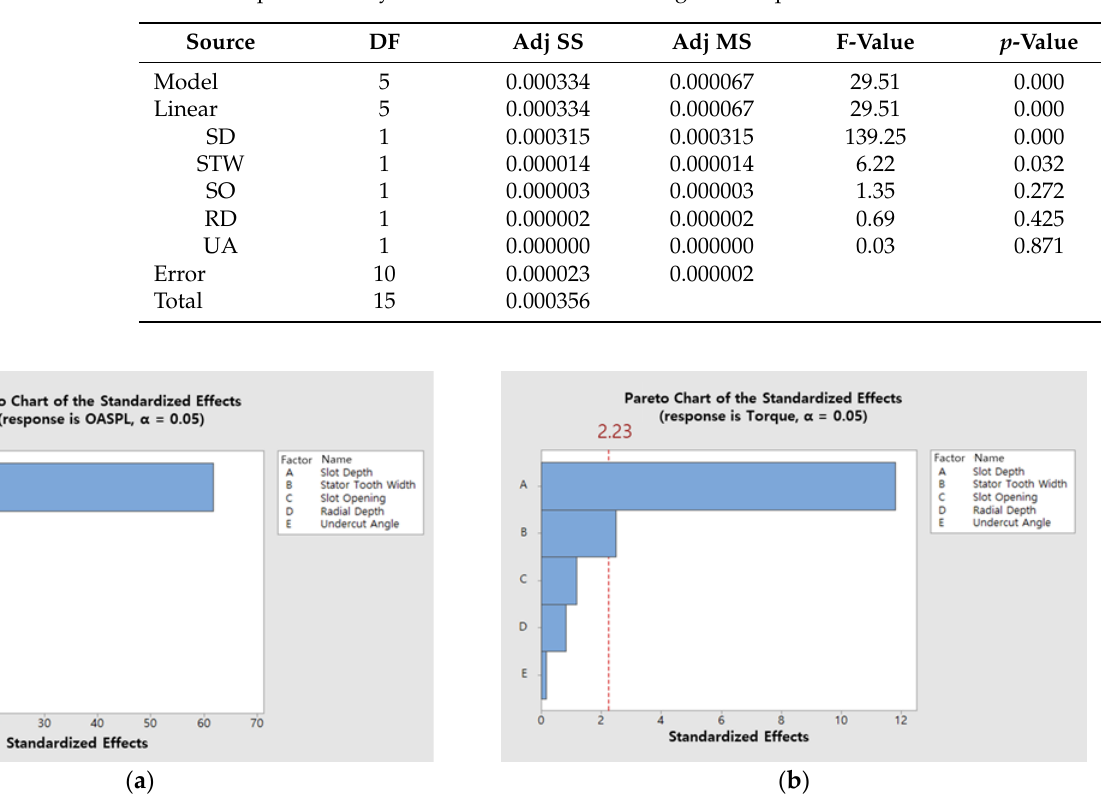
Table 5. Dispersion analysis of fractional factorial design for torque.